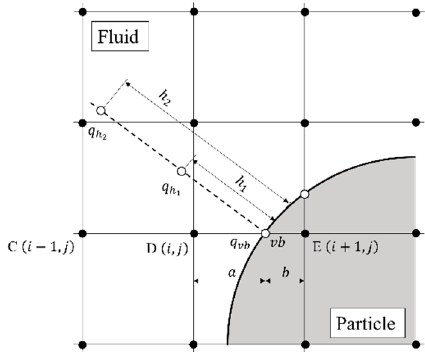
Figure 2. Schematic view of the VFM for a particle. a and b are internal division ratios across the virtual boundary. q vb is the physical quantity on virtual boundary